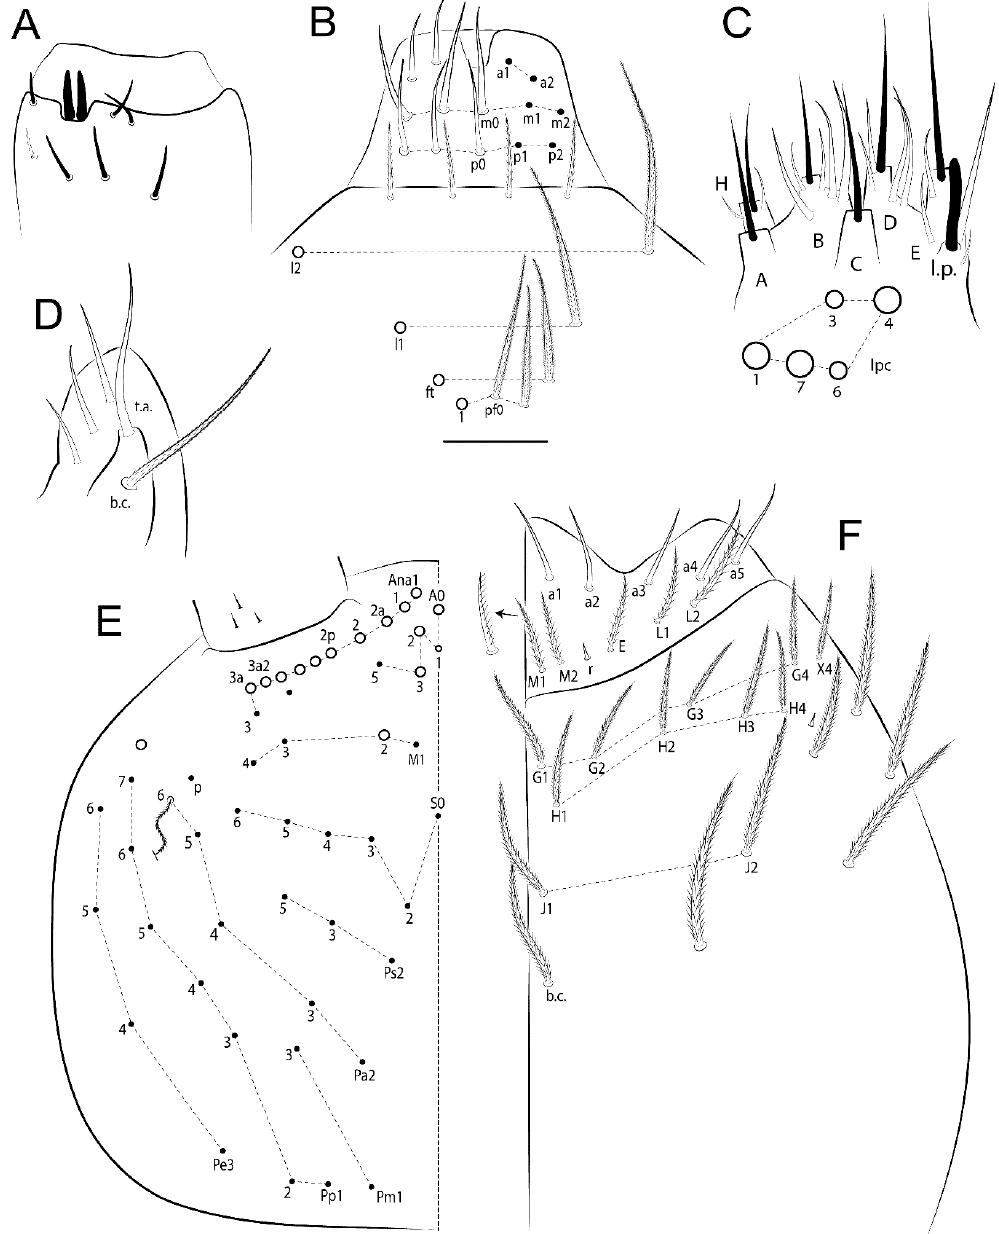
Figure 61. Pseudosinella spurimarianensis sp. nov.: head. ( A ) Ant III apical organ (ventro-lateral view); ( B ) chaetotaxy of clypeus, prelabrum, and labrum; ( C ) labial papillae plus proximal chaetae (right side); ( D ) maxillary palp and sublobal plate (right side), minute appendage omitted; ( E ) head dorsal chaetotaxy (left side); ( F ) basomedian and basolateral labial fields and complete postlabial chaetotaxy (right side).